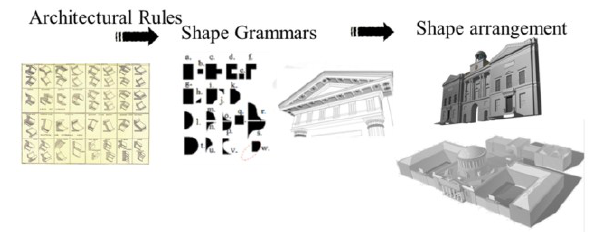
Figure 6: design for HBIM library of architectural